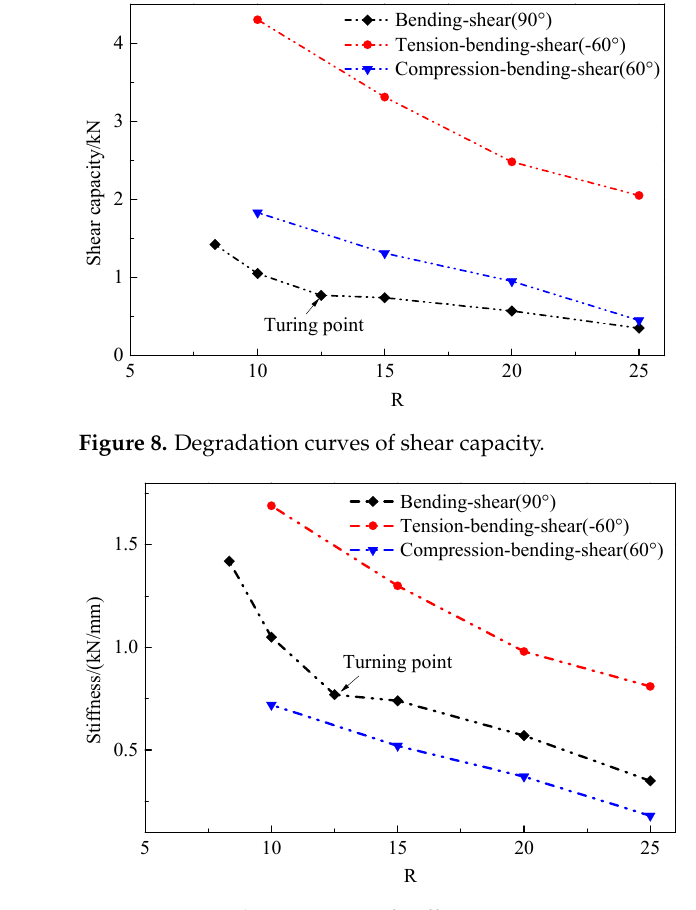
Figure 9. Degradation curves of stiffness. The failure modes and stiffness of specimen with different span ratios are listed in Table 5. bending-shear for specimens with installation angles of ± 60 ◦ . For tension-bending-shear specimens, the connectors experience inter-laminar shear failure when the span ratio is 10. The failure mode transforms from inter-laminar shear failure to connector fracture at the span ratio of 15. The connectors with a span ratio larger than 20 remain intact due to the stroke limit of the machine. However, for compression-bending-shear specimens, the specimens experience failure of connector fracture independent of span